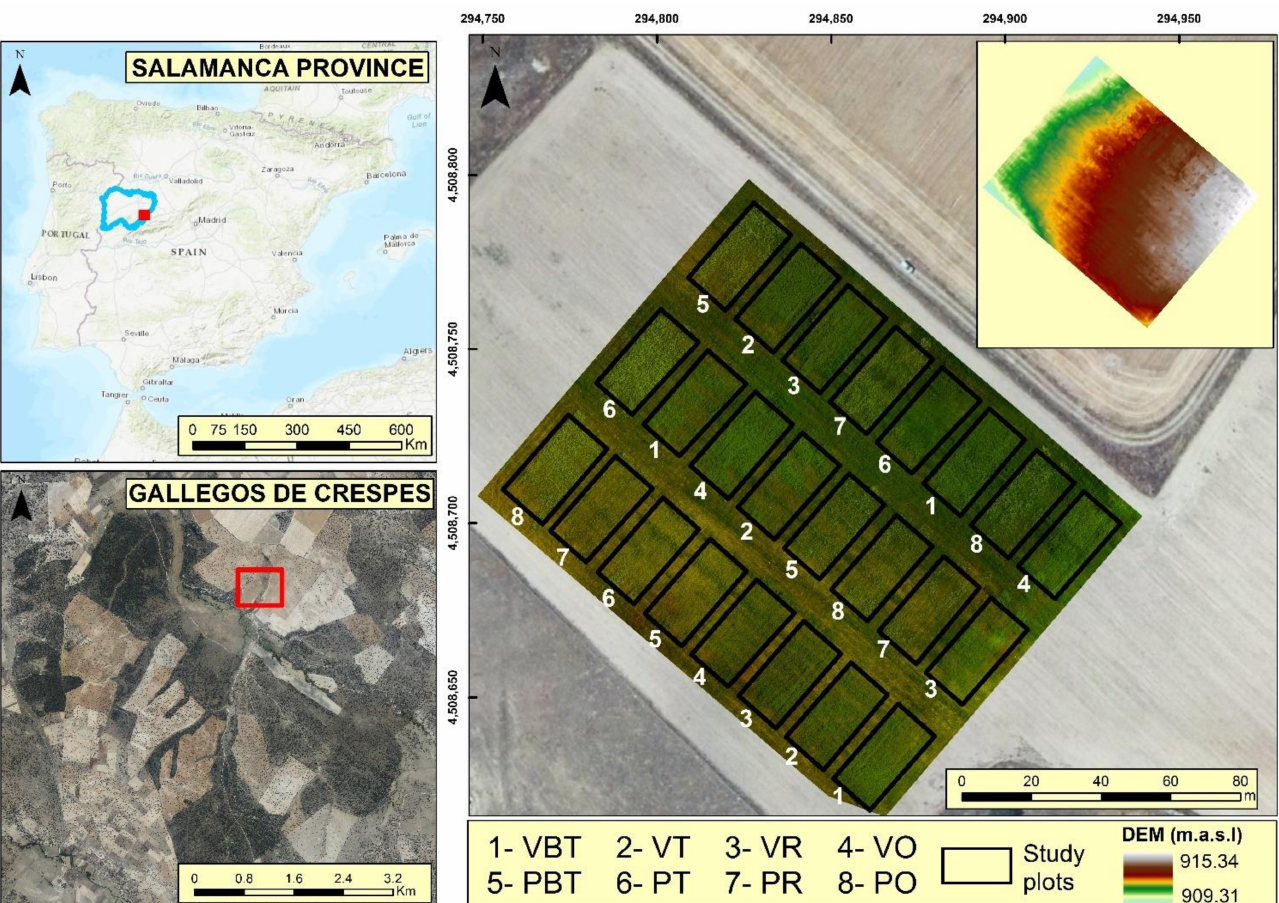
Figure 1. Farm location, experimental design and Digital Elevation Model (DEM) of the study area. VBT: vetch-barley-triticale, VT: vetch-triticale, VR: vetch-rye VO: vetch-oats, PBT: pea-barley-triticale, PT: pea-triticale, PR: pea-rye and PO: